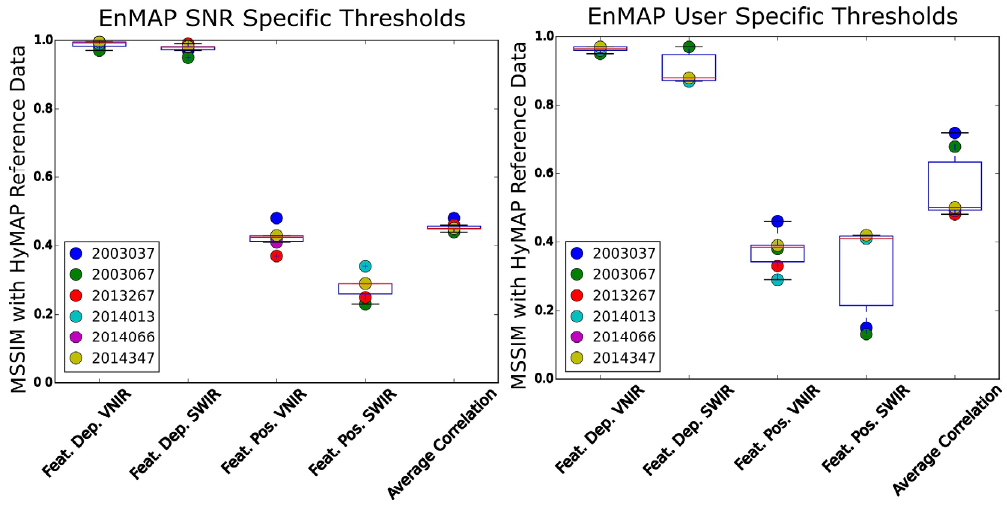
Figure 20. Comparison of the spectral (Feature Depth VNIR, Feature Depth SWIR), spatial (Feature Position VNIR, Feature Position SWIR) and material mapping performance (Average Correlation) at intersecting areas between simulated EnMAP data and the HyMAP reference data via the Mean Structural Similarity Index Measure. SNR specific thresholds depict the results from the sensor SNR specific EnGeoMAP 2.0 mapping approach, whilst the user specific thresholds depict the mapping results from fixed user defined absorption depth thresholds for the VNIR (2%) and the SWIR (3%).